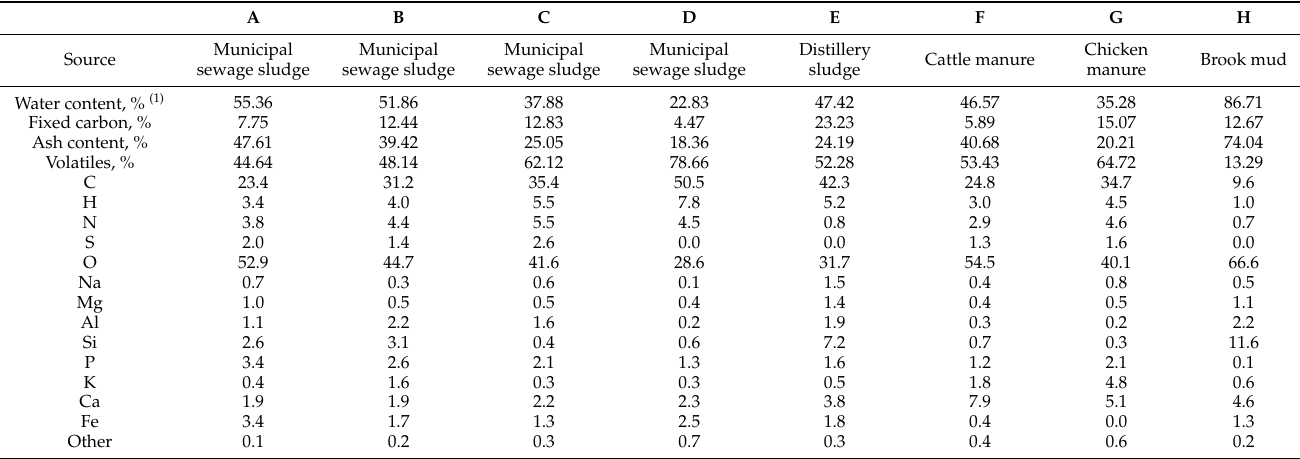
Table 2. Main properties of the dried sewage sludge